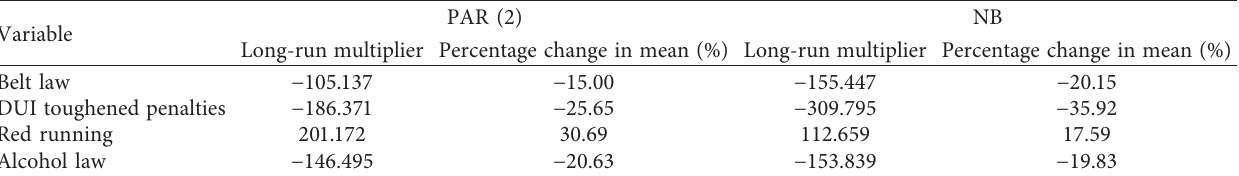
Table 4: Fatal traffic accident analysis (long-run effect).